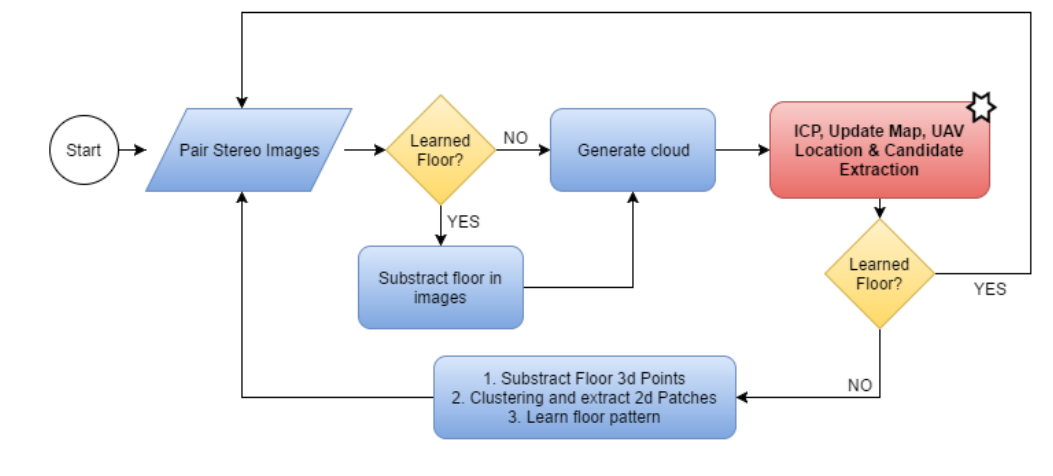
Figure 4. Floor detection and extraction flow